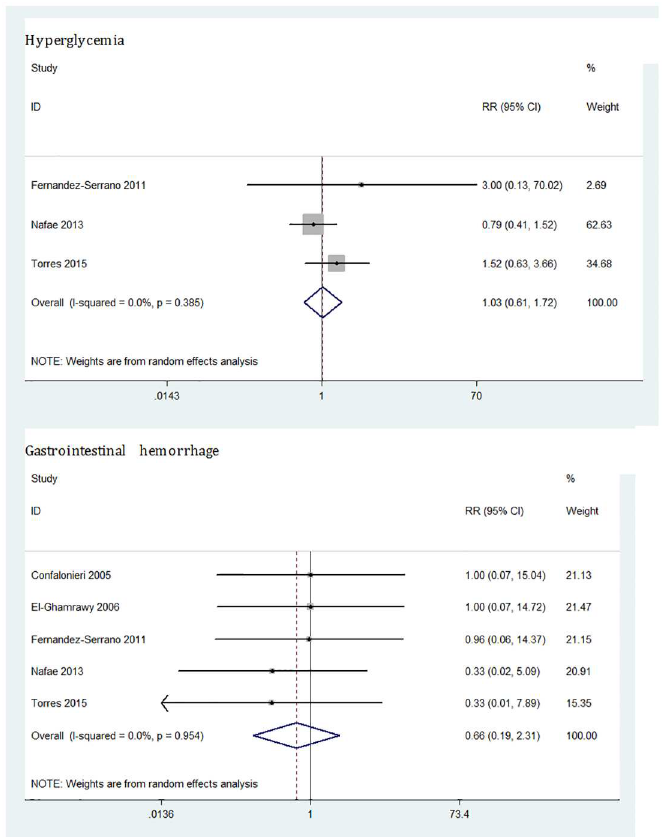
Fig 7. Effect of corticosteroids on hyperglycemia and gastrointestinal hemorrhage in severeCAP